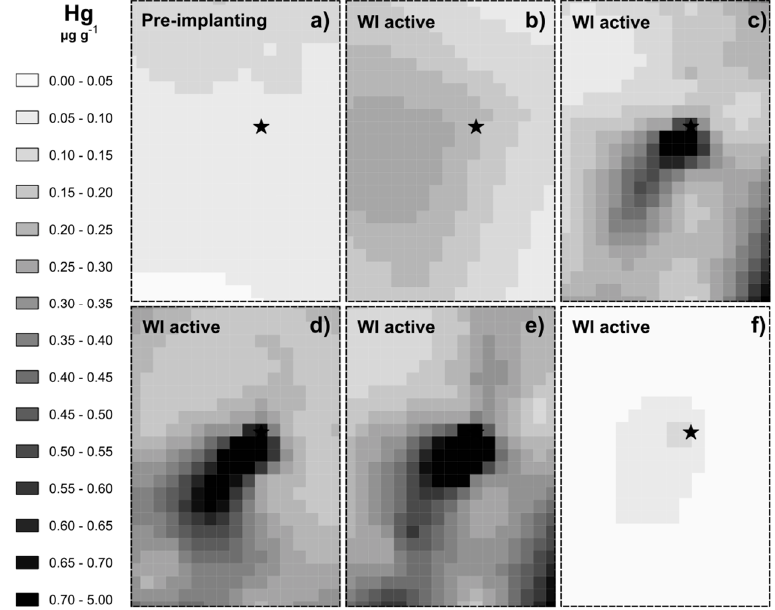
Table 4. Summary of interpolation analyses carried out on Xp 1999 , Xp 2007 , Pf-6 2008 , Pf-12 2008 , Pf-24 2008 , and Rp-G 2014 datasets. RMSE and VAR are expressed in µg g − 1 and correspond to the root mean square error and the local variability, respectively. Significant correlation values among interpolated values are reported in bold.